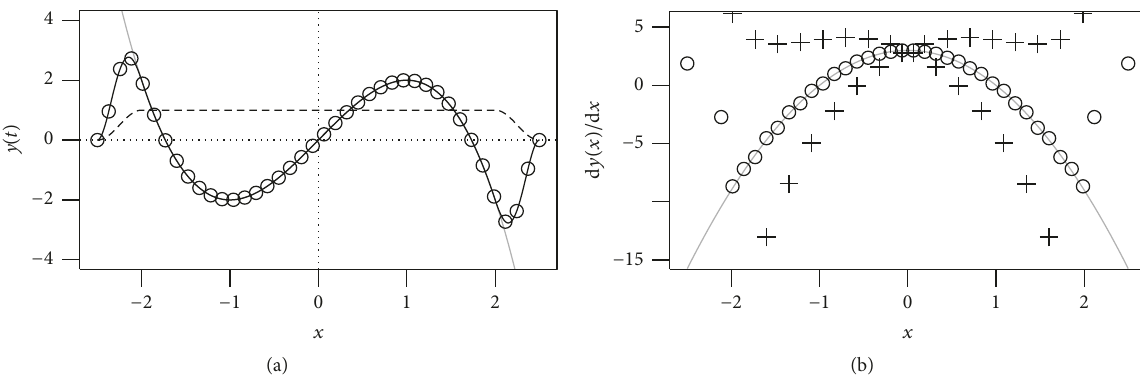
Figure 5: Calculating the derivative of 𝑦(𝑥) . (a) displays the original function (gray), the windowed function (black), and the sample points. The dashed line defines the window function. In (b), the analytic (gray line) and estimated numeric (points) derivative d 𝑦(𝑡)/ d 𝑥 is shown. The crosses indicate the result of the calculation without utilizing the window function. Note that some crosses are vertically outside the window for 𝑥 < −2 and 𝑥 > 2 .